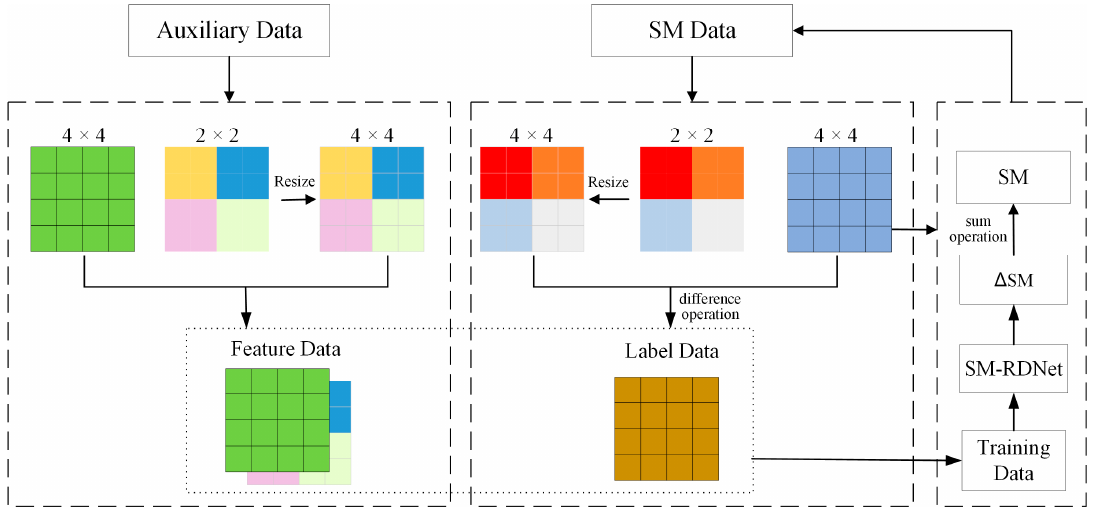
Figure 5. Flow chart of SM downscaling.